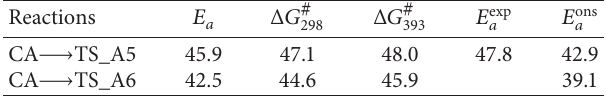
Table 3: Calculated data in gas-phase and in water solvent at various temperatures when compared with the experimental data. Reactions